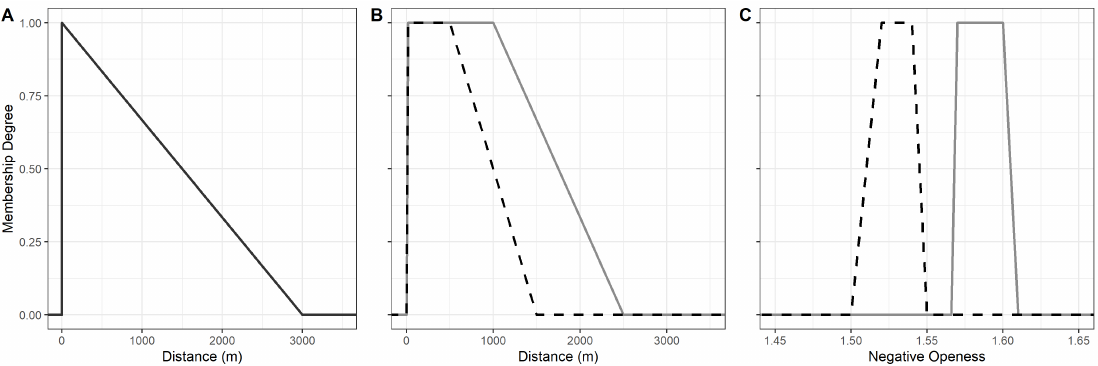
Figure 2. Fuzzification functions defining ( A ) a membership degree of the Fuzzy Set Flint available nearby for each distance to moraine areas; ( B ) a membership degree for reindeer hunters (gray) and elk hunters (black dotted) for each distance to recent water bodies and mires; and ( C ) a membership degree for the fuzzy set valley (gray) and ridge (black dotted) for each negative openness value [38].